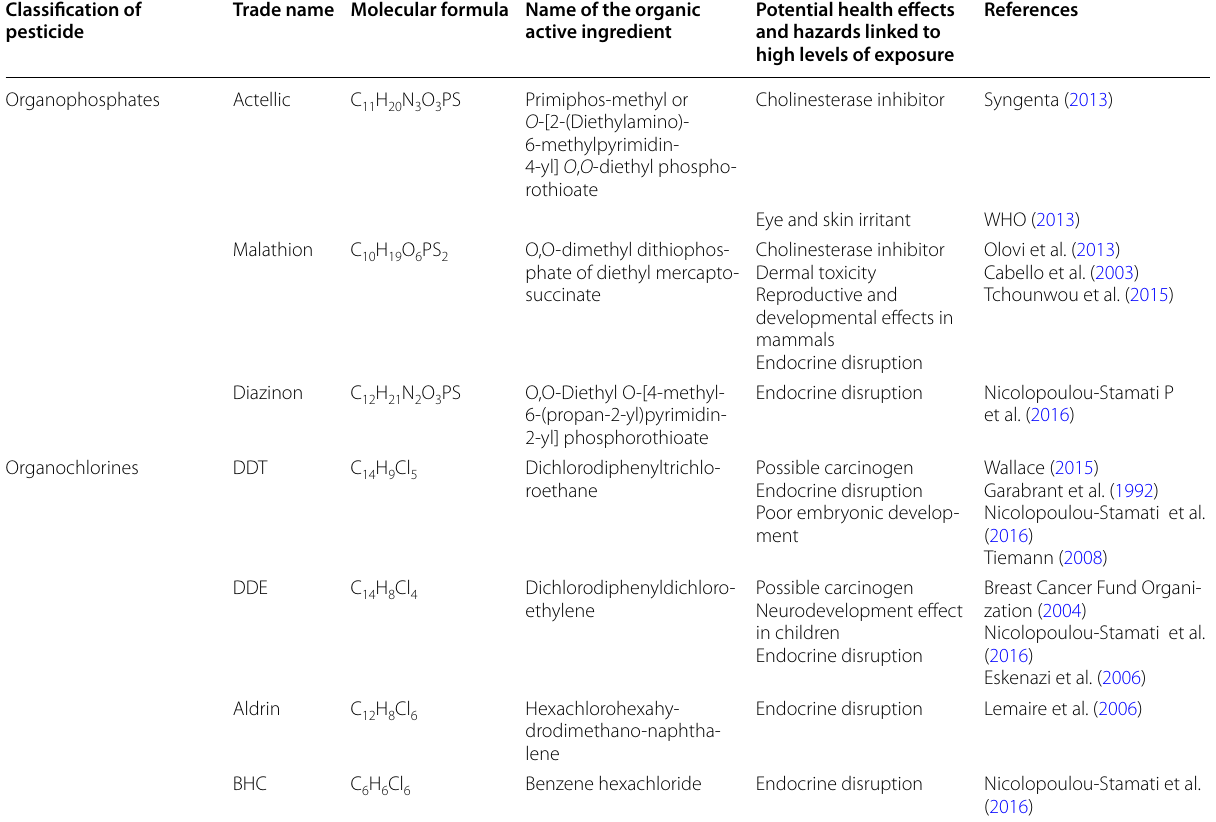
Table 6 Potential health effects associated with organophosphate and organochlorine pesticides applied in khat farming Classification of